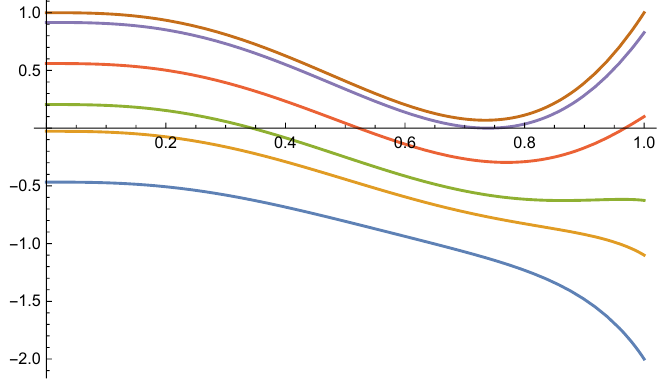
Figure 6: Plots of h ( ξ ) — cf. eq. (53) — for several values of the α/β ratio: The blue line is for ( α/β ) = 1, the orange line is for for ( α/β ) = 0.7, the green line is for ( α/β ) = 0.543 (transition), the red line is for ( α/β ) = 0.3, the violet line is for ( α/β ) = 0.0575 (transition), the brown line is for ( α/β ) = 0.